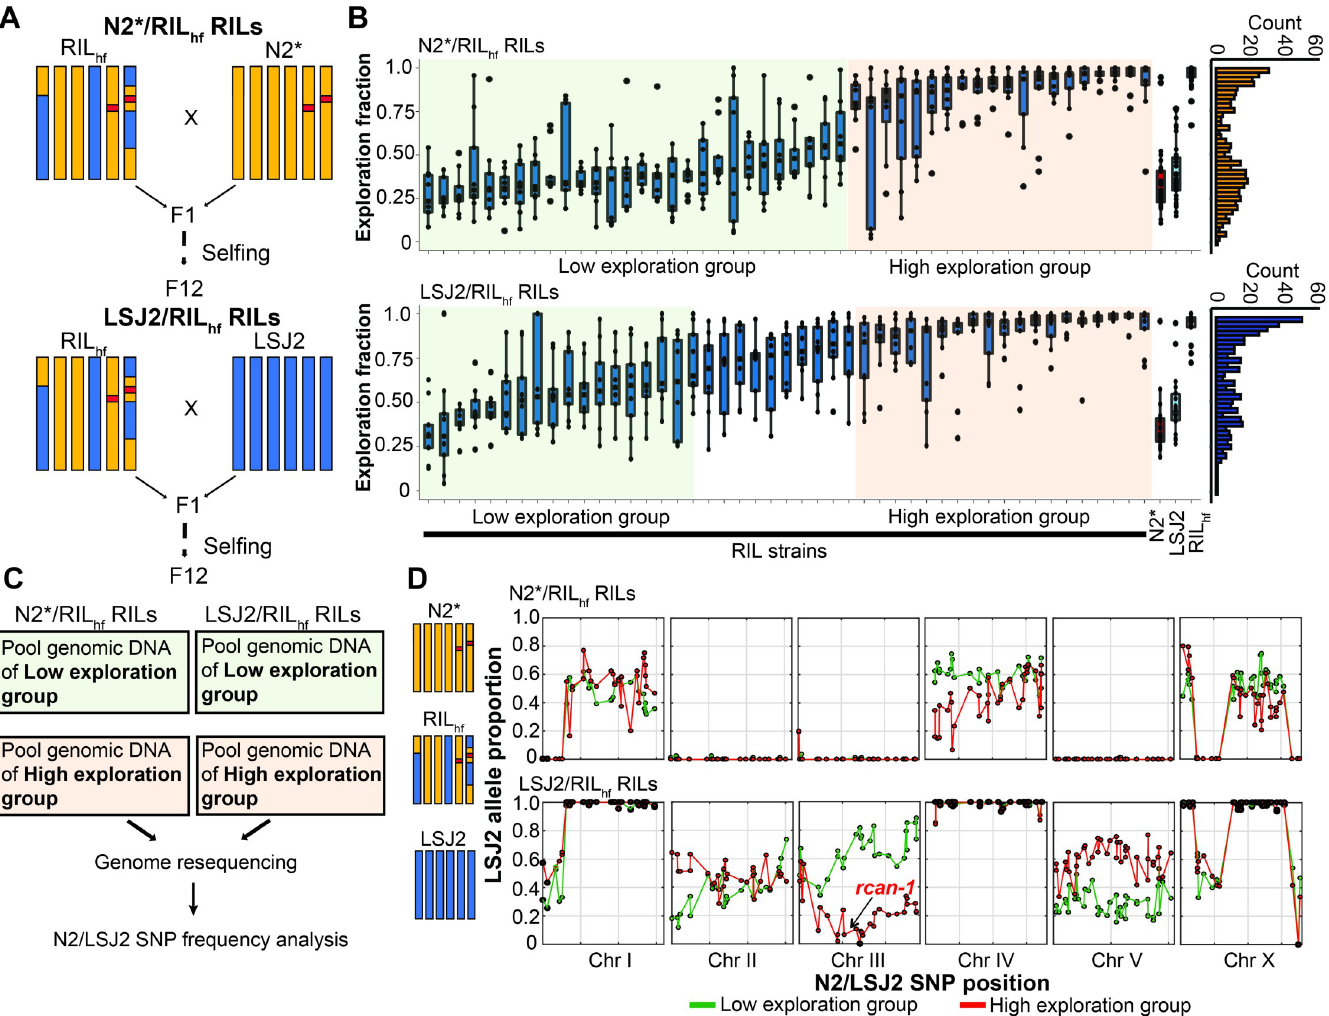
Fig 3. Exploration behavior differences of the RIL hf strain maps to the center of chromosome III. (A) To map the changes in RIL hf exploration behavior and fitness, we generated two panels of RILs (n = 48) between the RIL hf and N2 � strains or the RIL hf and LSJ2 strains. (B) Each RIL was measured for exploration behavior using the assay shown in Fig 2C . Color coding shows how strains were combined into low (green) or high (orange) groups for bulk-segregant analysis. Uncolored RILs were not included. The histograms on the right displayed the distribution of RIL’s exploratory fraction. (9 replicates were performed for each RIL). (C) Overview of bulk- segregant approach using pooled genomic DNA to calculate LSJ2/N2 allele frequency. (D) Allele frequency for LSJ2/N2 genetic differences was calculated for each population. A large allelic frequency difference was observed on chromosomes III and V in the LSJ2/RIL hf .